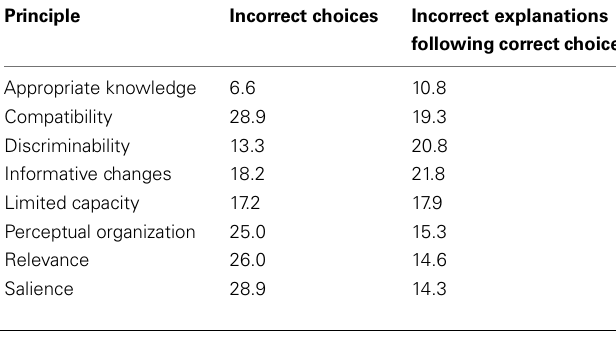
explanations of correct choices, by principle, in Study 3.